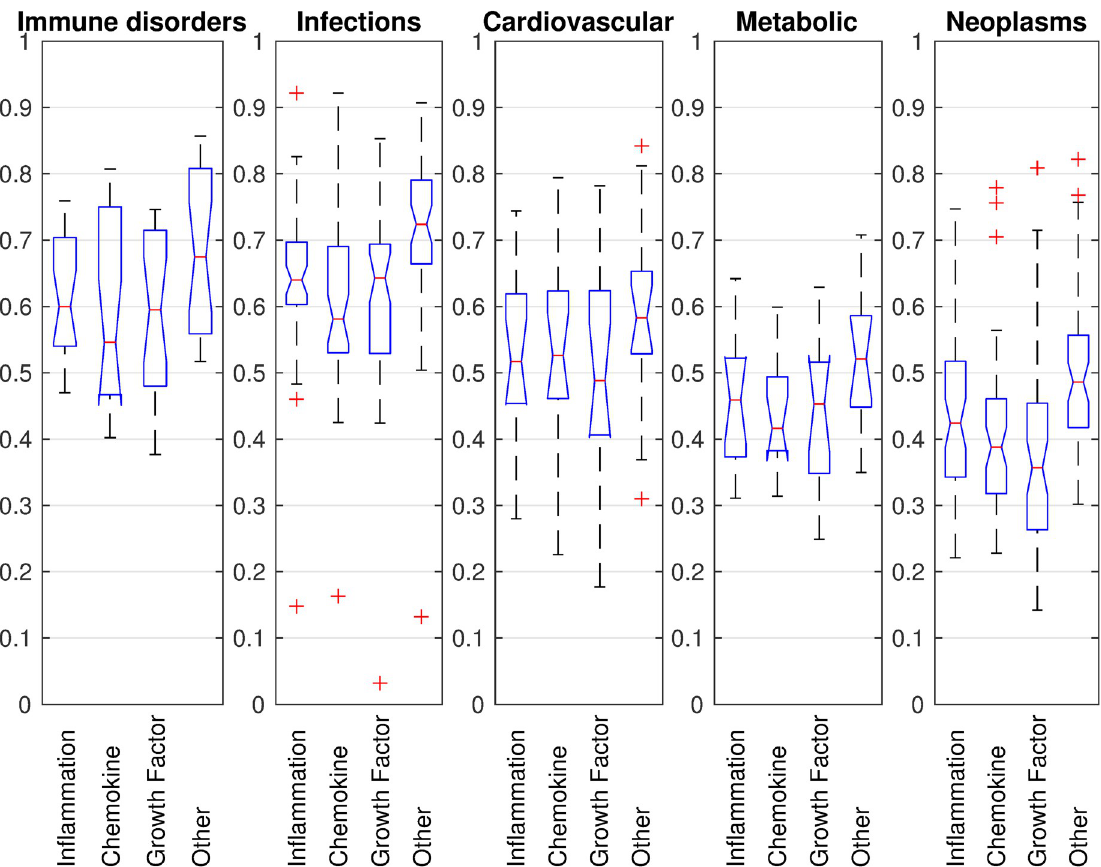
Fig 7. Cytokine features for the 171 well-studied diseases. The 171 diseases formed three clusters based on their NASS with different types of cytokines. Immune disorders are enriched in cluster-1. Infections are split into two clusters (cluster-1 and cluster-2). Note that of the twenty neoplasms in cluster-1, nineteen are hematic and lymphatic diseases (C15/C04). Most metabolic diseases (11/13) and cardiovascular disorders (11/17) are enriched in cluster-3. Note that diseases of other classes are not counted in the labels. Cluster details are in Table D in S1